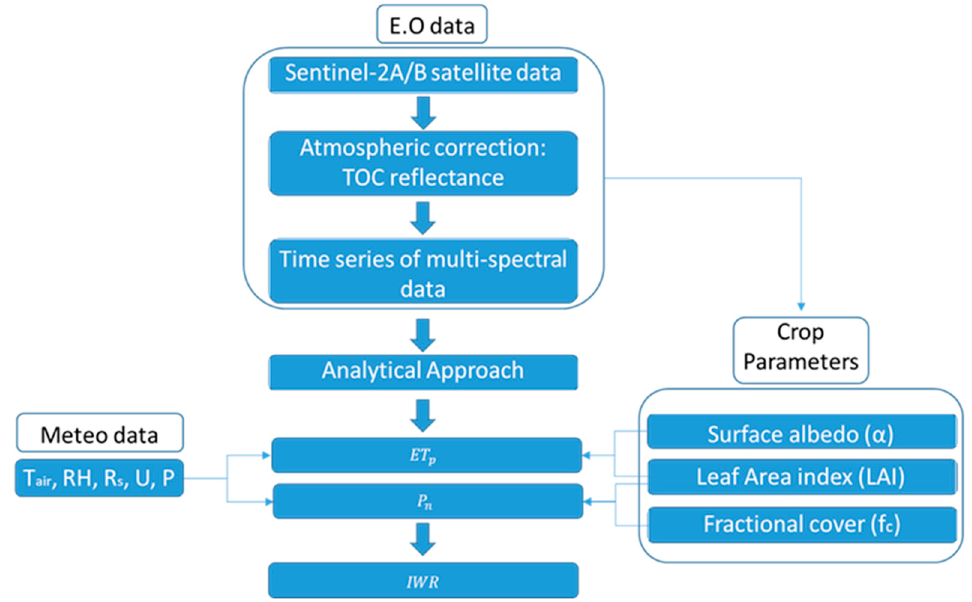
Figure 2. Flowchart shows dataset and processing procedure required to estimate crop potential evapotranspiration (ETp), and irrigation water requirements (IWR), Earth Observation-based direct FAO-56 Penman-Monteith equation method. Legend: Ta = air temperature, RH = relative humidity; Rs = solar radiation; U = wind speed; P = precipitation.